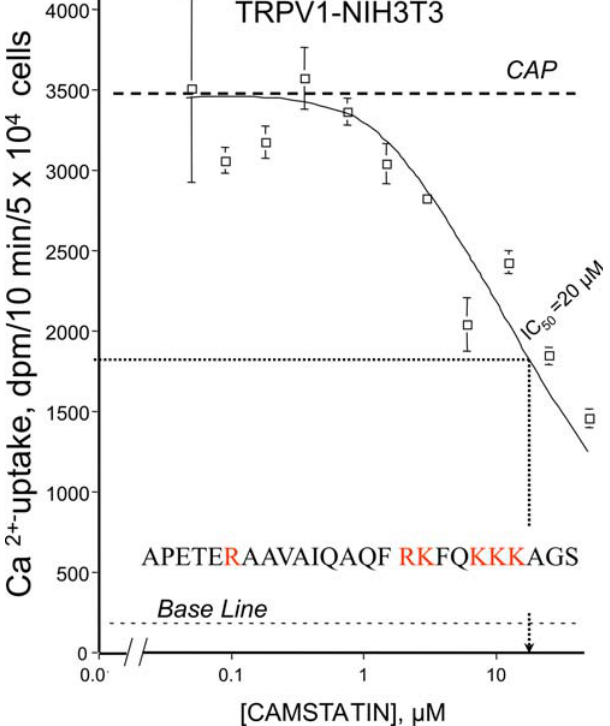
calmodulin on TRPV1-mediated Ca 2 + -transport. Camstatin, a recently identified, selective, 25-mer polypeptide blocker of calmodulin, was employed, which inhibited capsaicin-induced Ca 2 + -uptake with com- parable activity (IC 50 =20 m M) determined previously to other, more conventional antagonists, of calmodulin in TRPV1-NIH3T3 cells. Results with camstatin suggests calmodulin-like structure at the extracellular domains of TRPV1. Experiments were repeated two additional times in triplicate with similar results.